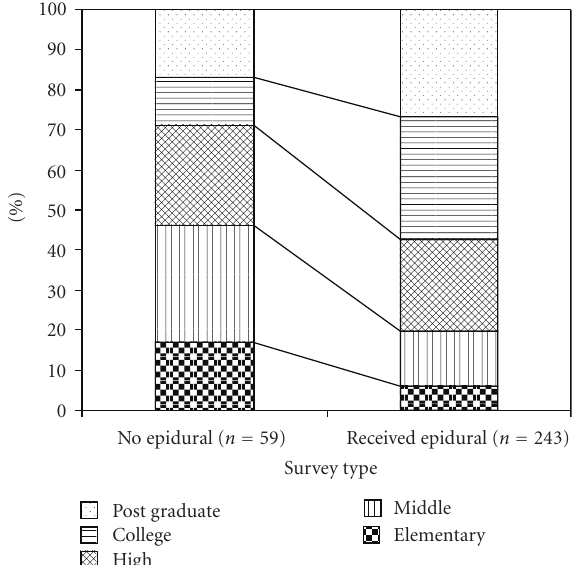
Figure 1: The highest educational level achieved by the women surveyed. Women receiving labor epidurals had a higher overall educational level ( P < . 05).